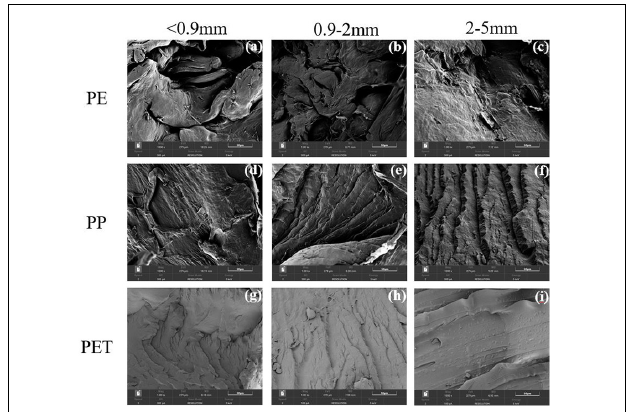
FIGURE 3 | (a–i) The morphology of PE, PP and PET microplastics.